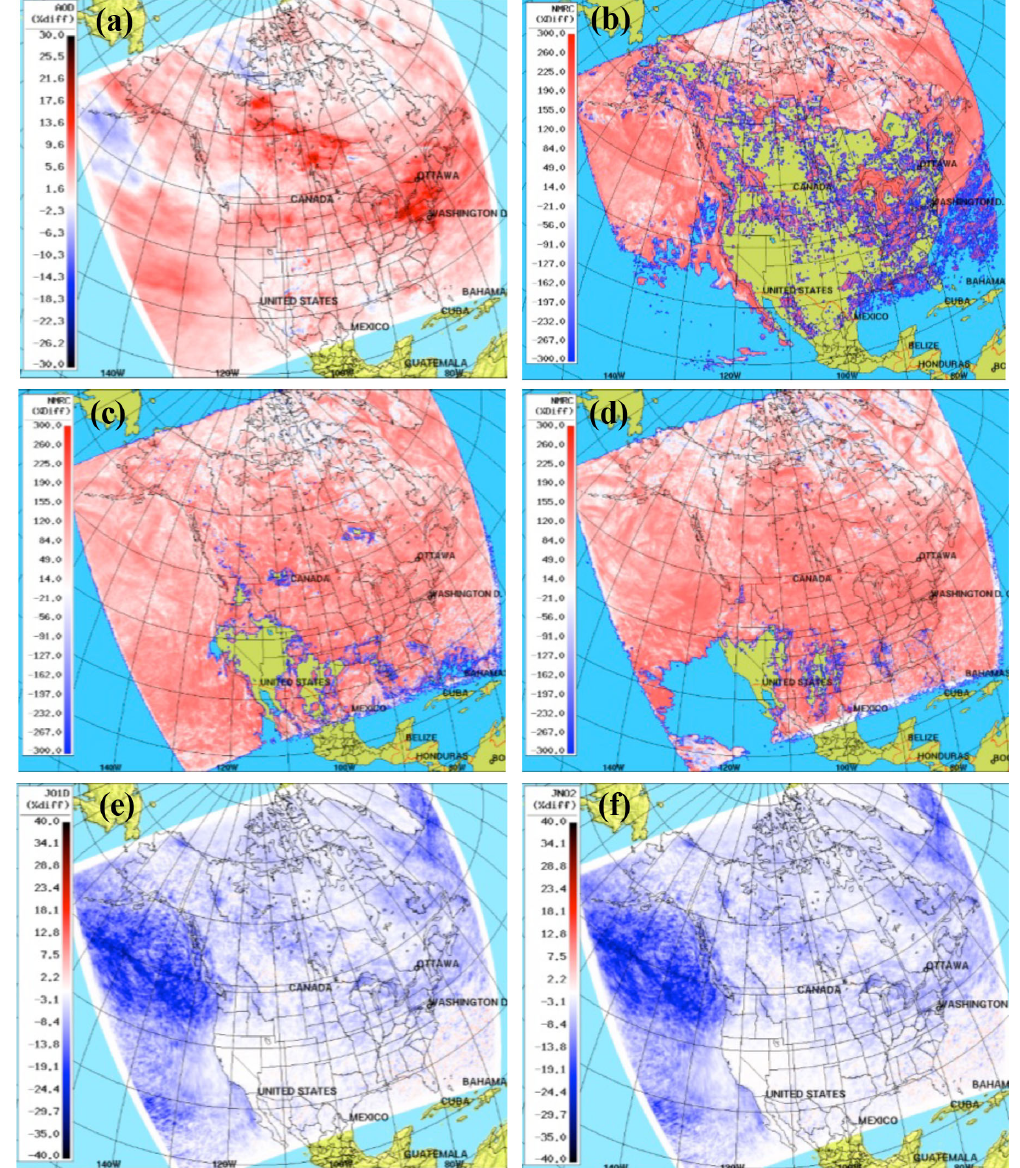
Figure 11. Percentage difference in daytime monthly average (June 2018) of (a) AOD, (b–d) number mixing ratio of clouds at 120, 900m and 2km above ground level, respectively, (e) J O 1 D at the lowest model level and (f) J NO 2 at the lowest model level, with and without online aerosol